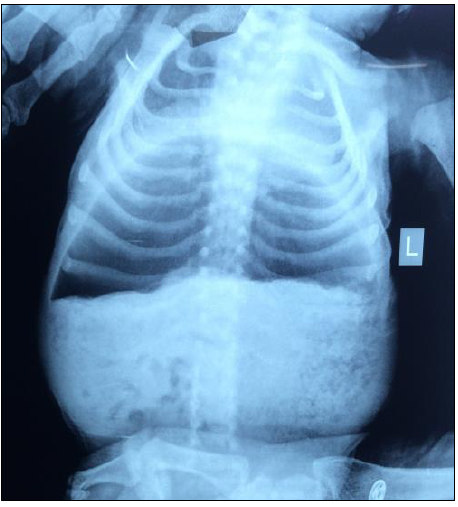
Figure 1: X-ray abdomen-erect showing huge air shadow in the upper